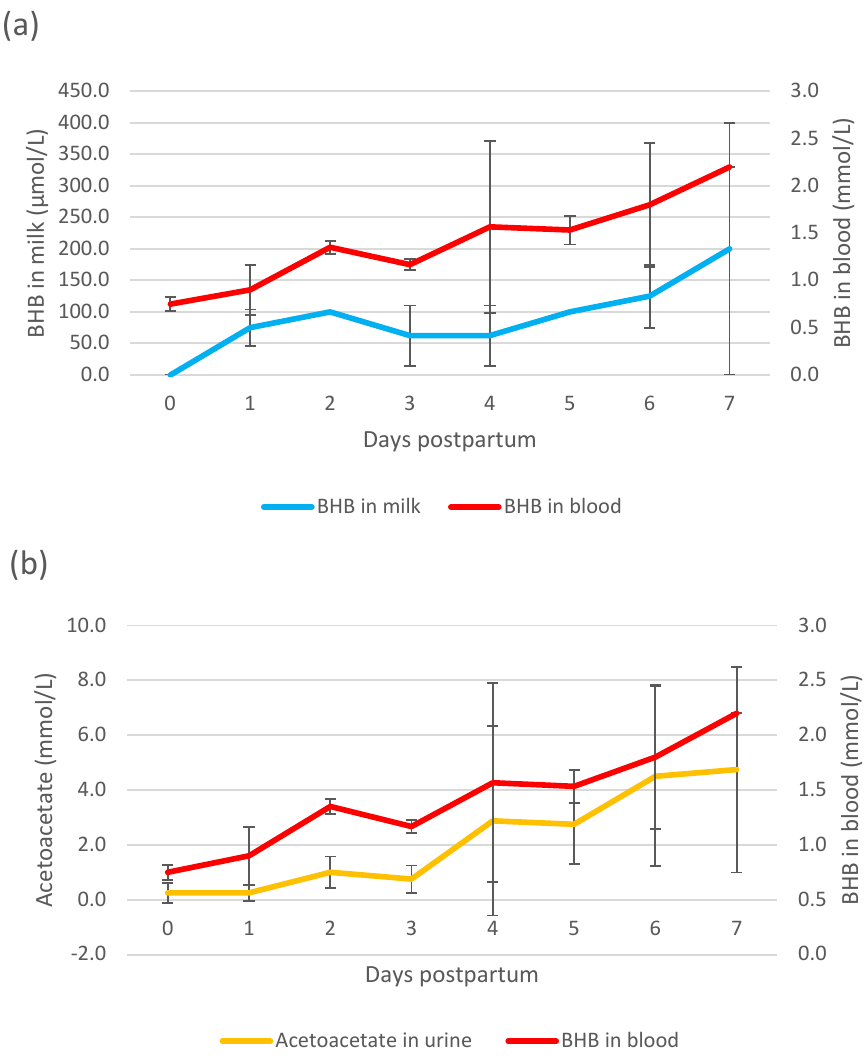
Figure 8. Concentration of BHB in blood and BHB in milk ( a ) and acetoacetate in urine ( b ) (±SD) for four ketotic cows, daily samples until seven days postpartum.